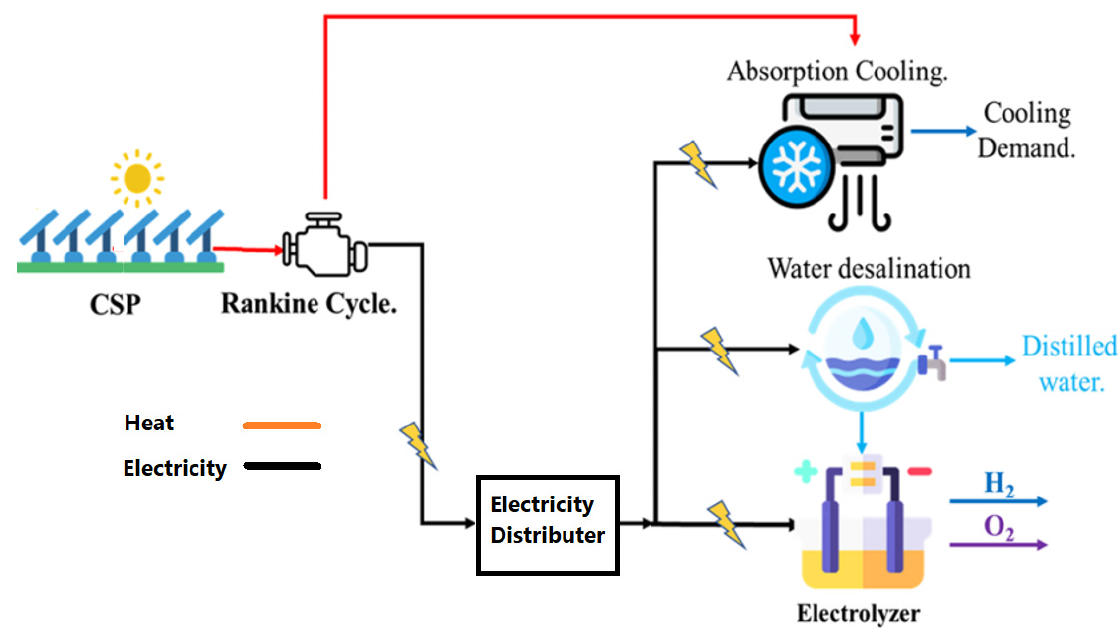
Figure 18. Principal of concentrated CSP/H 2 multi-generation system.